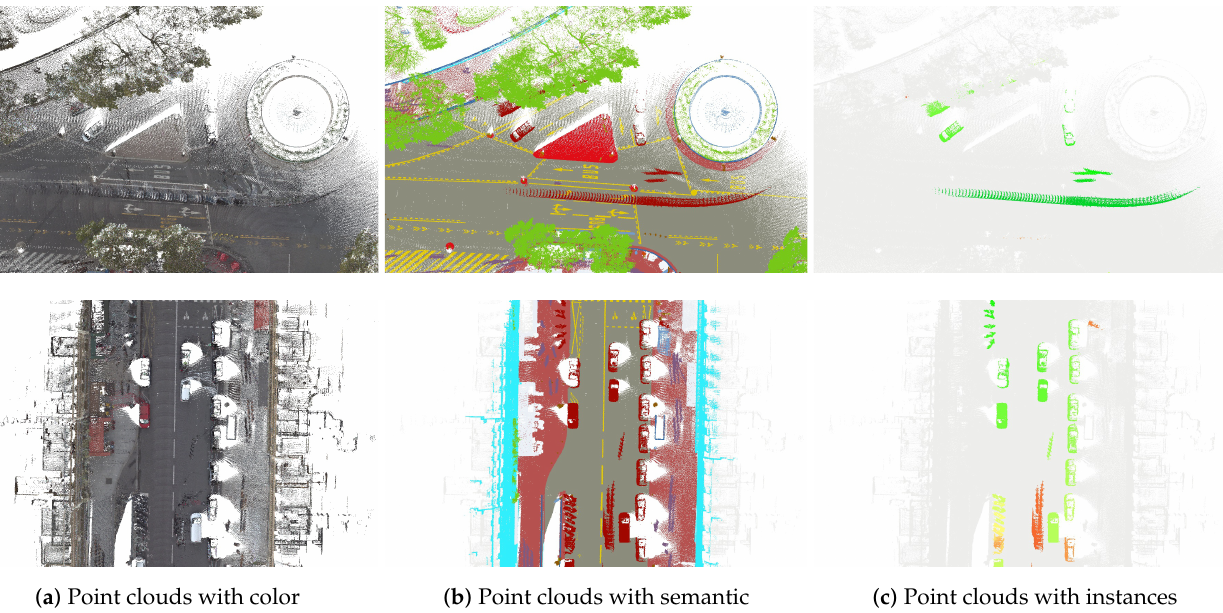
Figure A1. Paris Training set . From top to bottom: S 1 , S 2 (real data). Figure A1. Paris training set. From top to bottom : S 1 , S 2 (real